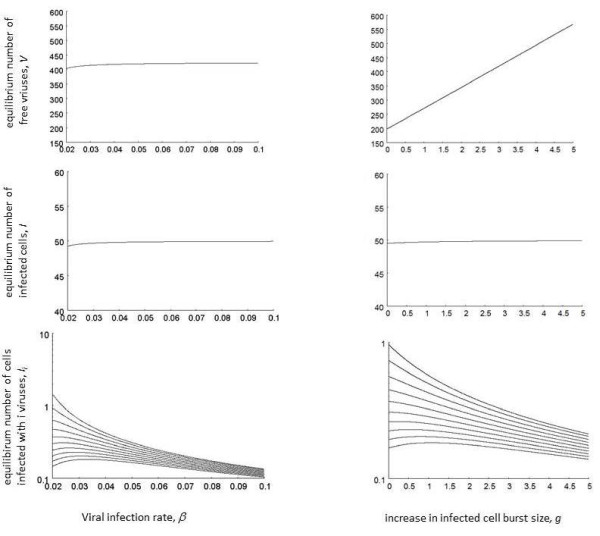
Effect of viral replication parameters on equilibrium virus load in the model with increased burst size in coinfected cells, expressed as different measures: free virus, the number of infected cells, and different subpopulation of infected cells. We plotted cells infected with 1, 10, 20, 30 40, 50 60, 70, 80, 90 viral copies, going from the top curve to the bottom curve. While the average number of viruses per cell has been reported to be around 3–4 in the context of HIV replication in tissues, cells infected with a significantly higher copy number have been reported to exist in HIV. See text for details. Base parameters were chosen as follows. λ = 10; d = 0.1; β = 0.05; a = 0.2; k = 4; u = 1; ϵ = 1; g = 0.75; η = 0.5; n = 200.